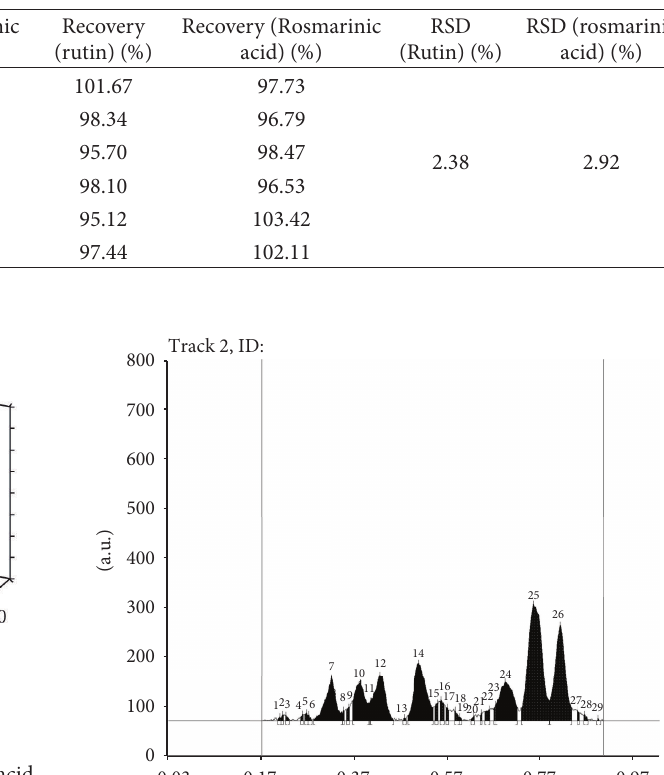
F 3: HPTLC chromatograms of rutin and rosmarinic acid mixture and ASMq samples.